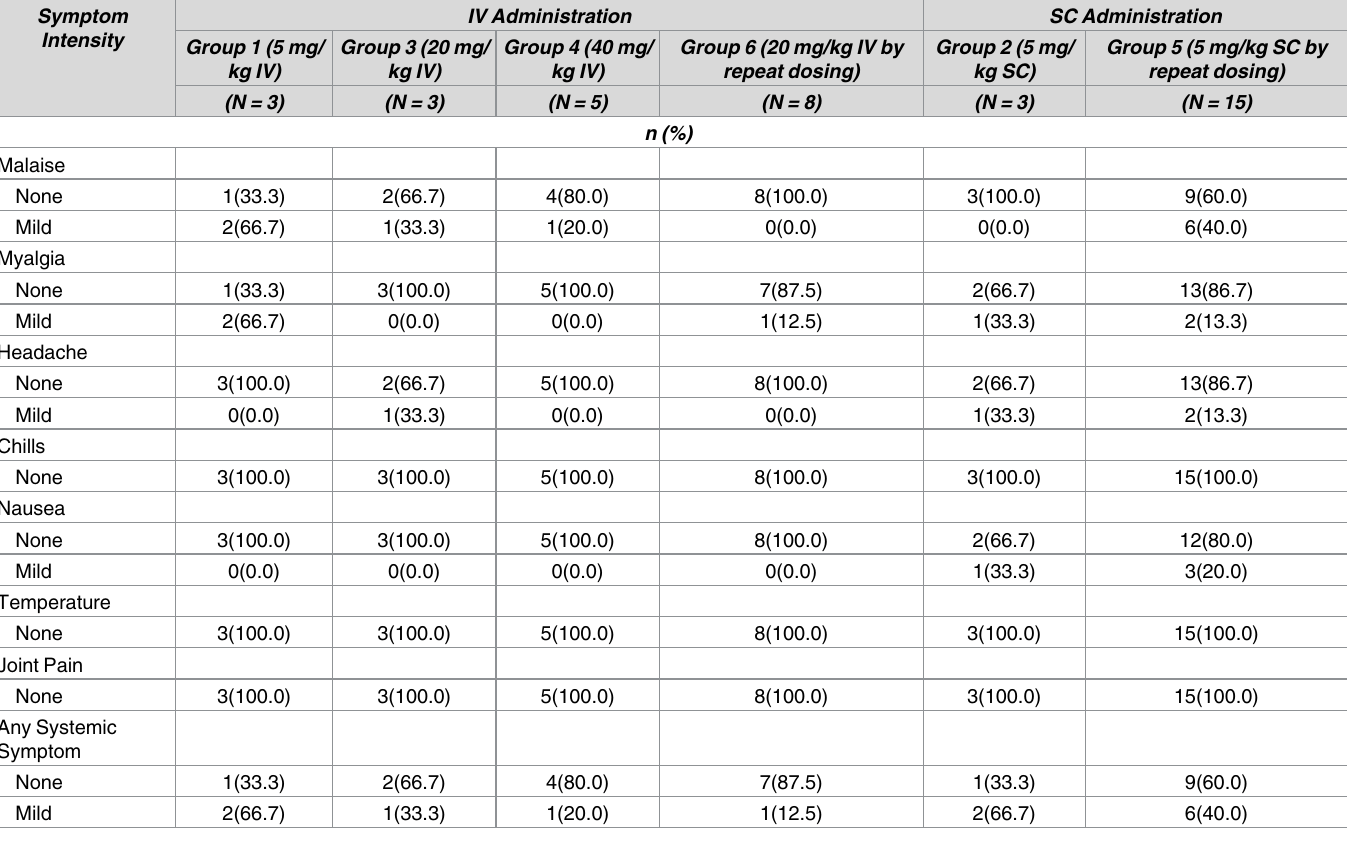
Table 3. Self-reported systemicreactogenicity up to 3 days after VRC01LS administration *